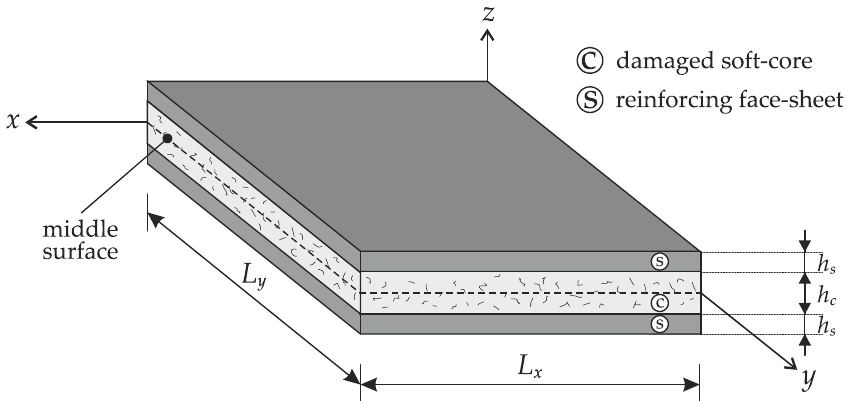
Figure 1. Geometric features of a laminated sandwich plate with an inner damaged soft-core.